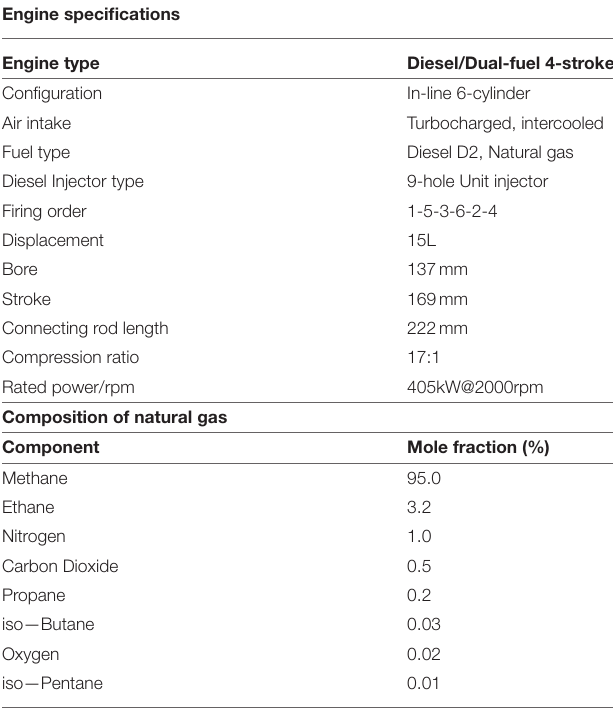
TABLE 1 | Test Engine and natural gas